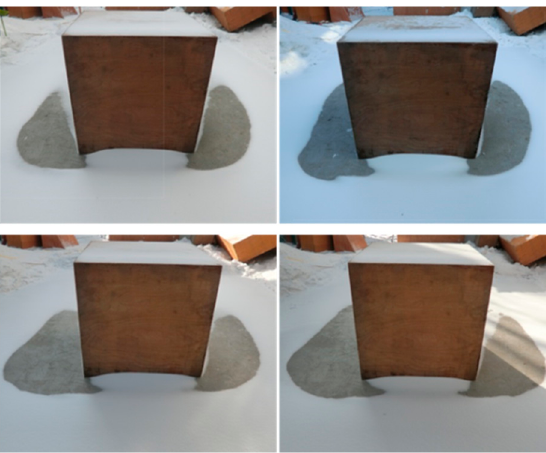
Figure 7. Some photos of the repetitive experiments.